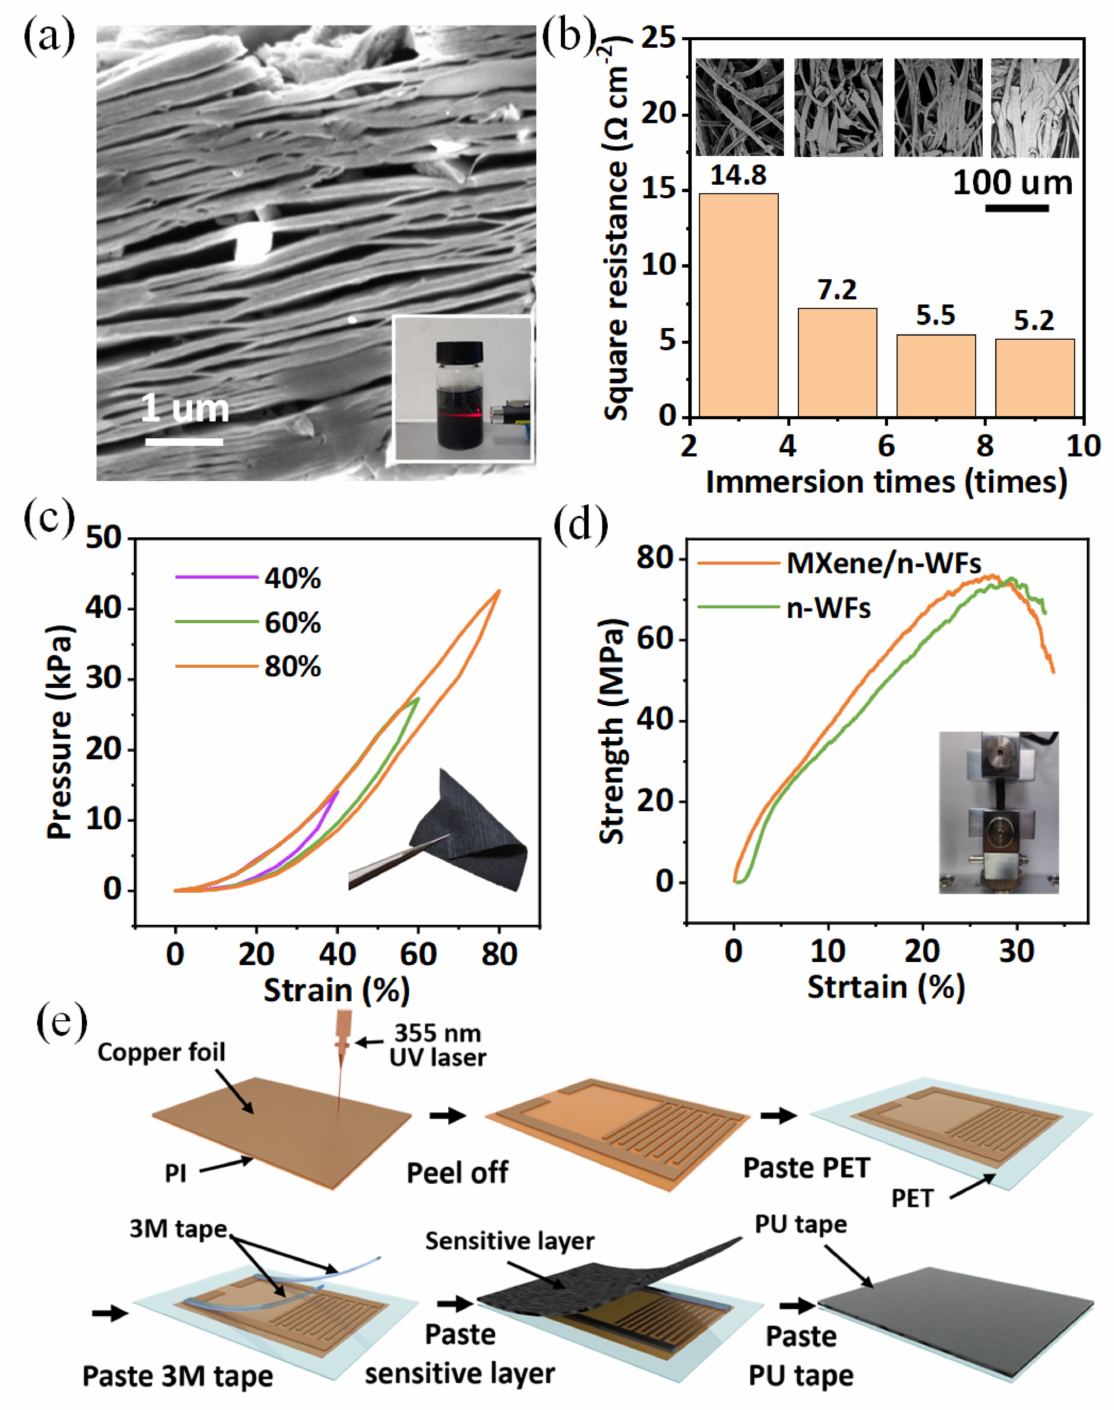
Figure 2. ( a ) SEM image of Ti 3 C 2 T x nanosheet and Tyndall effect of Ti 3 C 2 T x nanosheets solution; ( b ) morphology and square resistance of the n-WFs coated for 3, 5, 7, and 9 times; ( c ) compression test’s comparison under various strains; ( d ) tensile test of the n-WFs and MXene/n-WFs; ( e ) fabricated process of